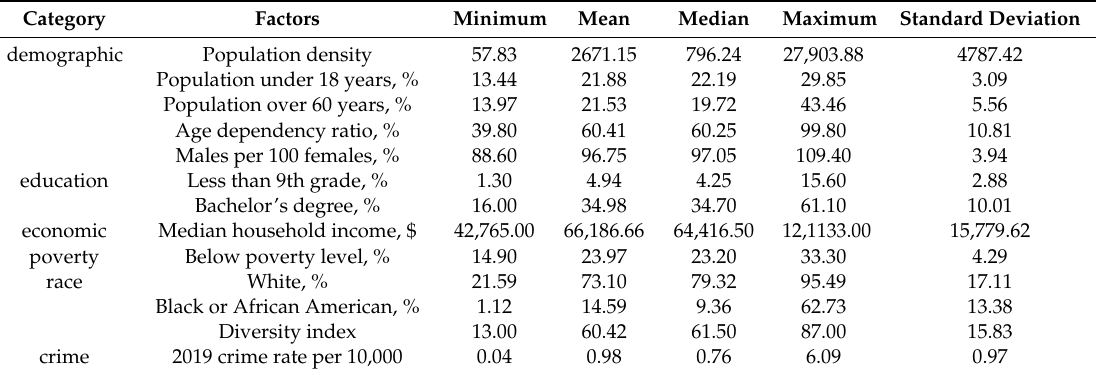
Table 2. Descriptive statistics for independent